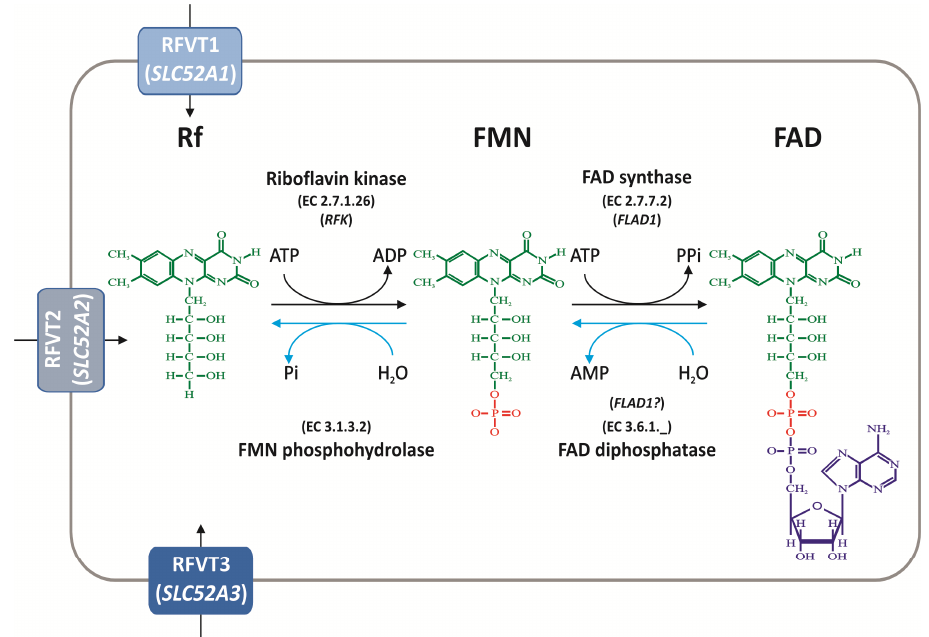
Figure 1. Chemical structures and metabolic conversion of Riboflavin (Rf) and flavin cofactors in man. The chemical structures of Rf, flavin mononucleotide (FMN) and flavin adenine dinucleotide (FAD)